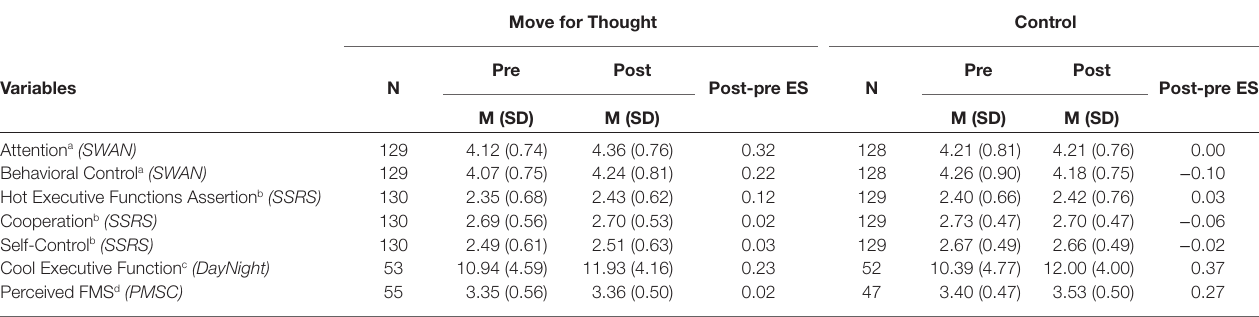
TABLE 2 | Means (and standard deviations) per outcome as a function of condition. Variables